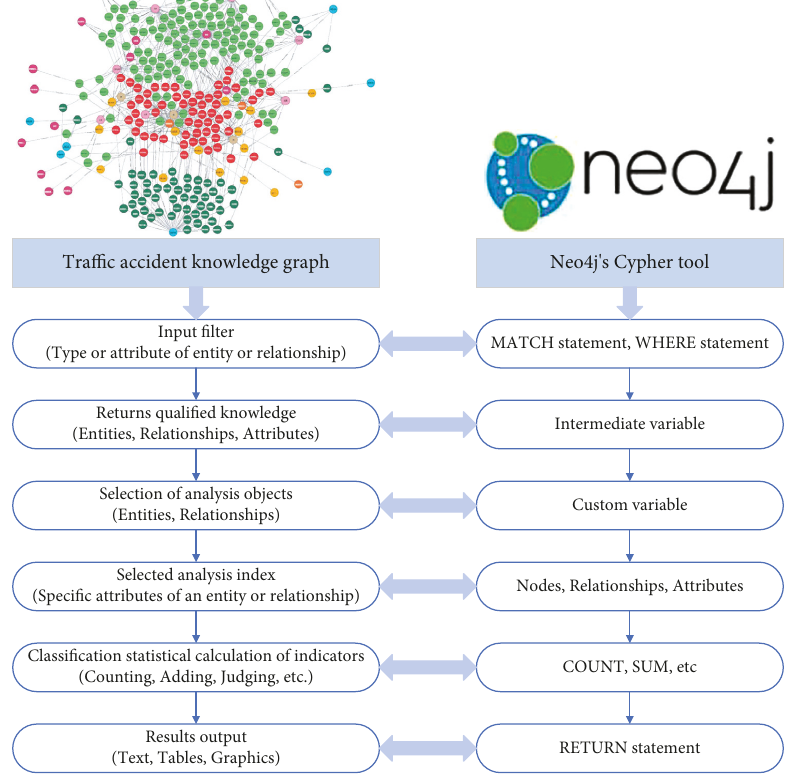
Figure 7: Traffic accident analysis process based on knowledge